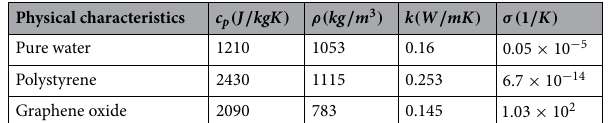
Physical characteristics